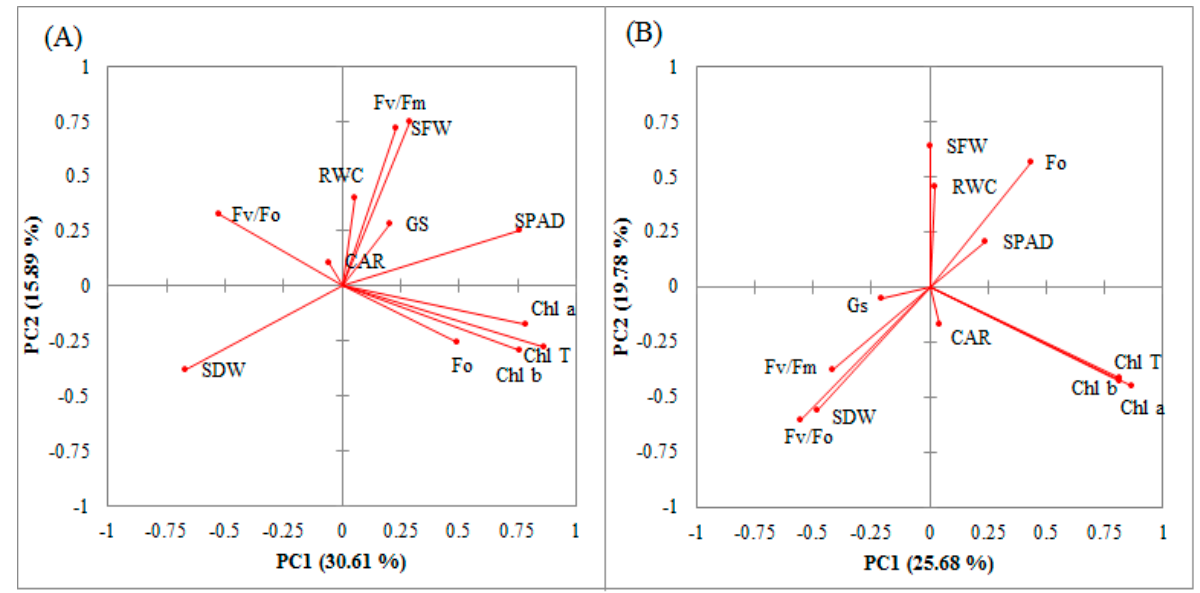
Figure 1. Biplots based on some photosynthetic-related parameters, physiological traits, and shoot biomass of the 95 investigated Ae. tauschii and T. aestivum species under control ( A ) and water-deficit stress ( B ) treatment. SPAD relative chlorophyll, Gs stomatal conductance, Fv/Fm maximum quantum yield of PSII, Fv/Fo maximum primary yield of PSII photochemistry, Fo initial fluorescence, Chl a chlorophyll a content, Chl b chlorophyll b content, Chl T total chlorophyll content, RWC leaf relative water content, CAR carotenoid content, SFB shoot fresh biomass, and SDB shoot dry biomass.